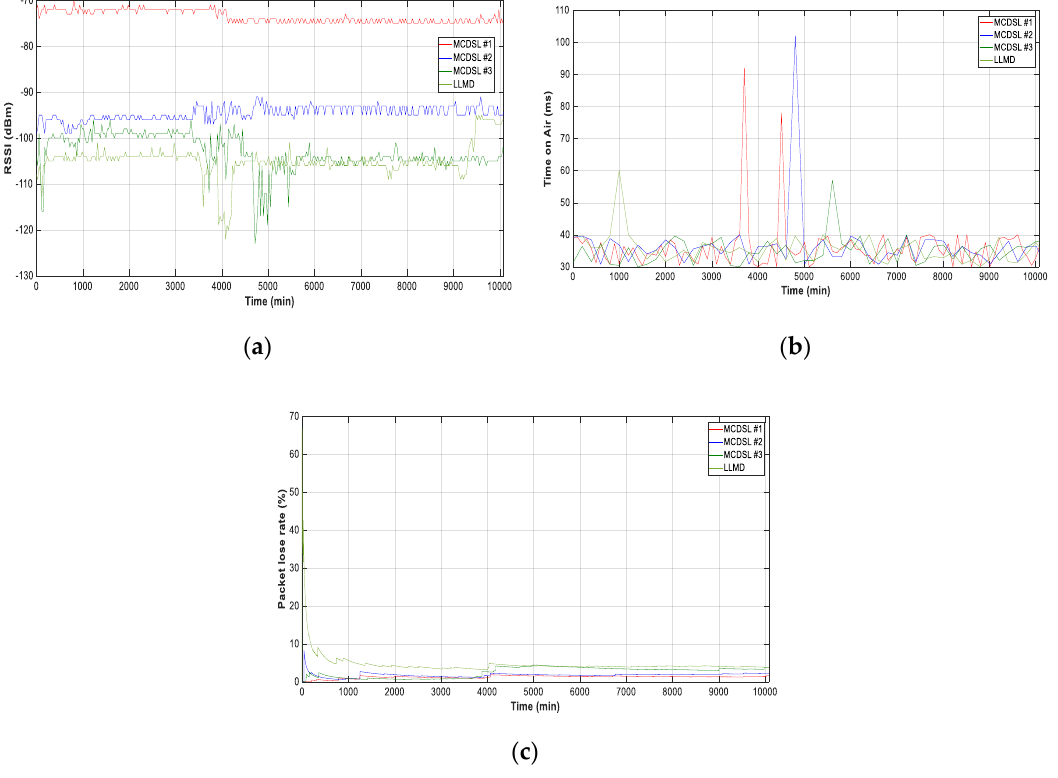
Figure 19. LoRa characteristic: ( a ) RSSI; ( b ) ToA; ( c ) PLR.